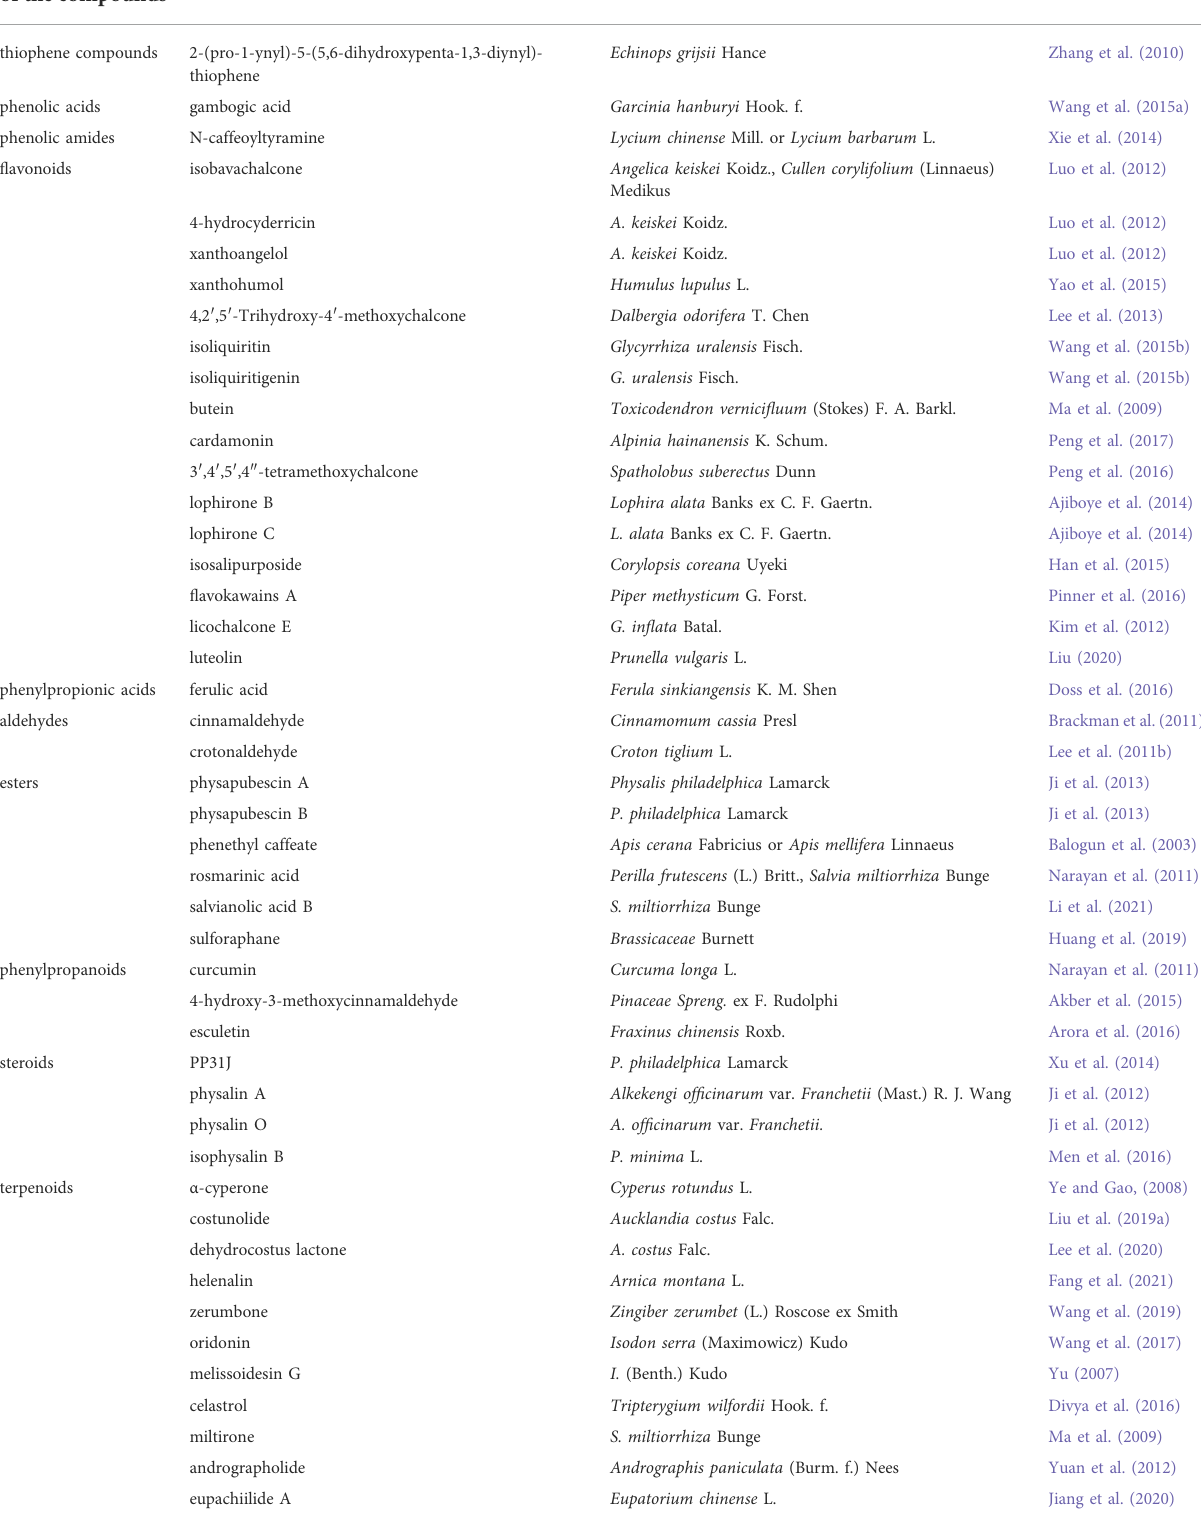
TABLE 1 MAMs from different sources in nature, the source and classi fi cation of these MAMs are shown in the